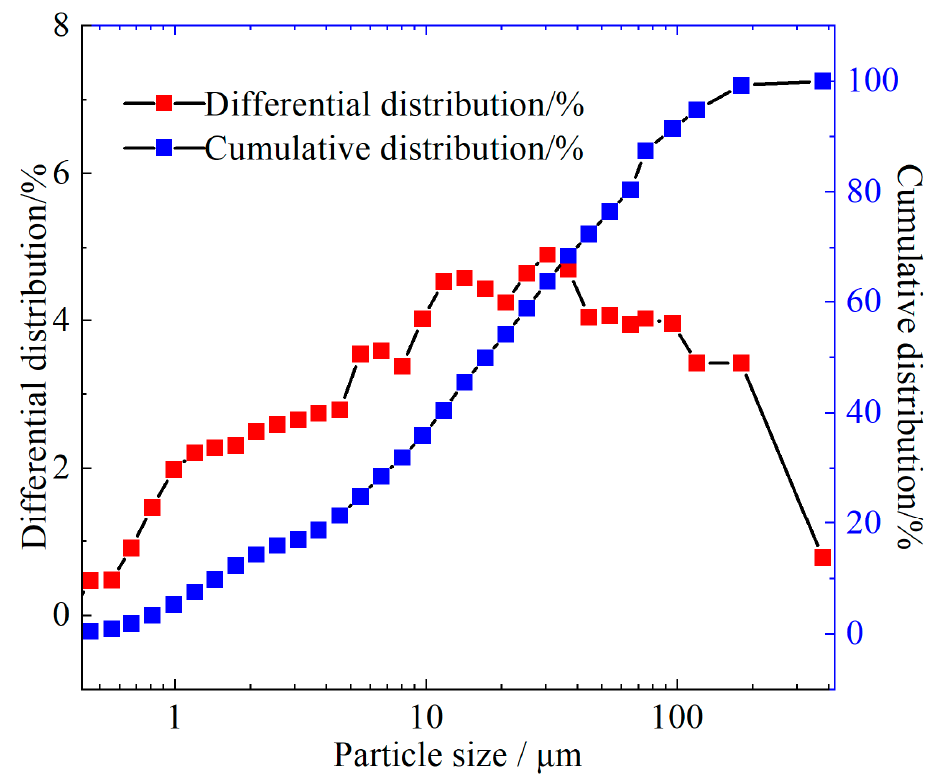
Figure 1. Particle size distribution of the unclassified tailings.